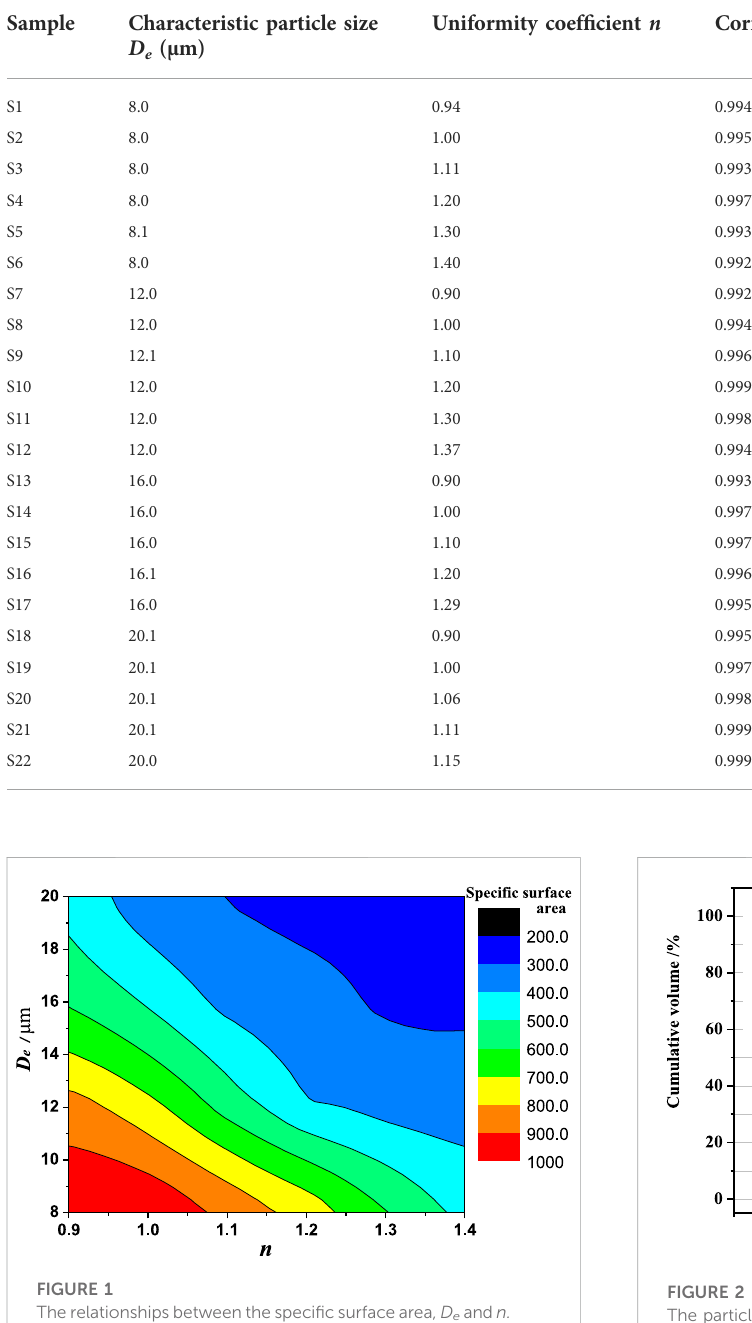
TABLE 2 The particle characteristics of GGBFS.